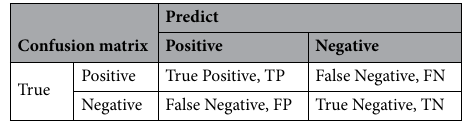
Table 2. Confusion